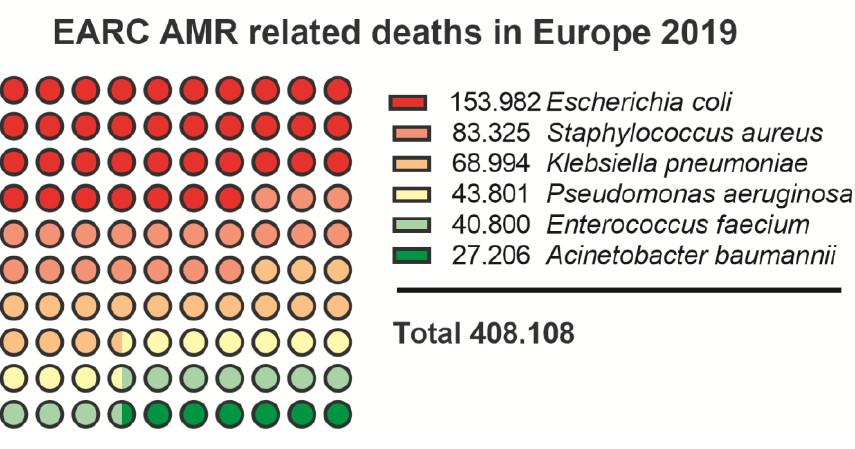
Figure 3. EARC nr. of deaths caused by ESKAPE pathogens in 2019 [138].